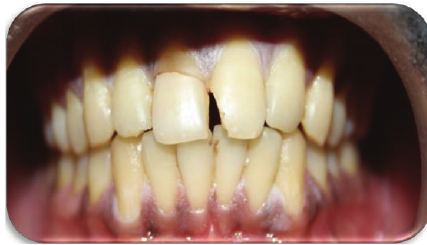
Figure 1: Preoperative photograph.